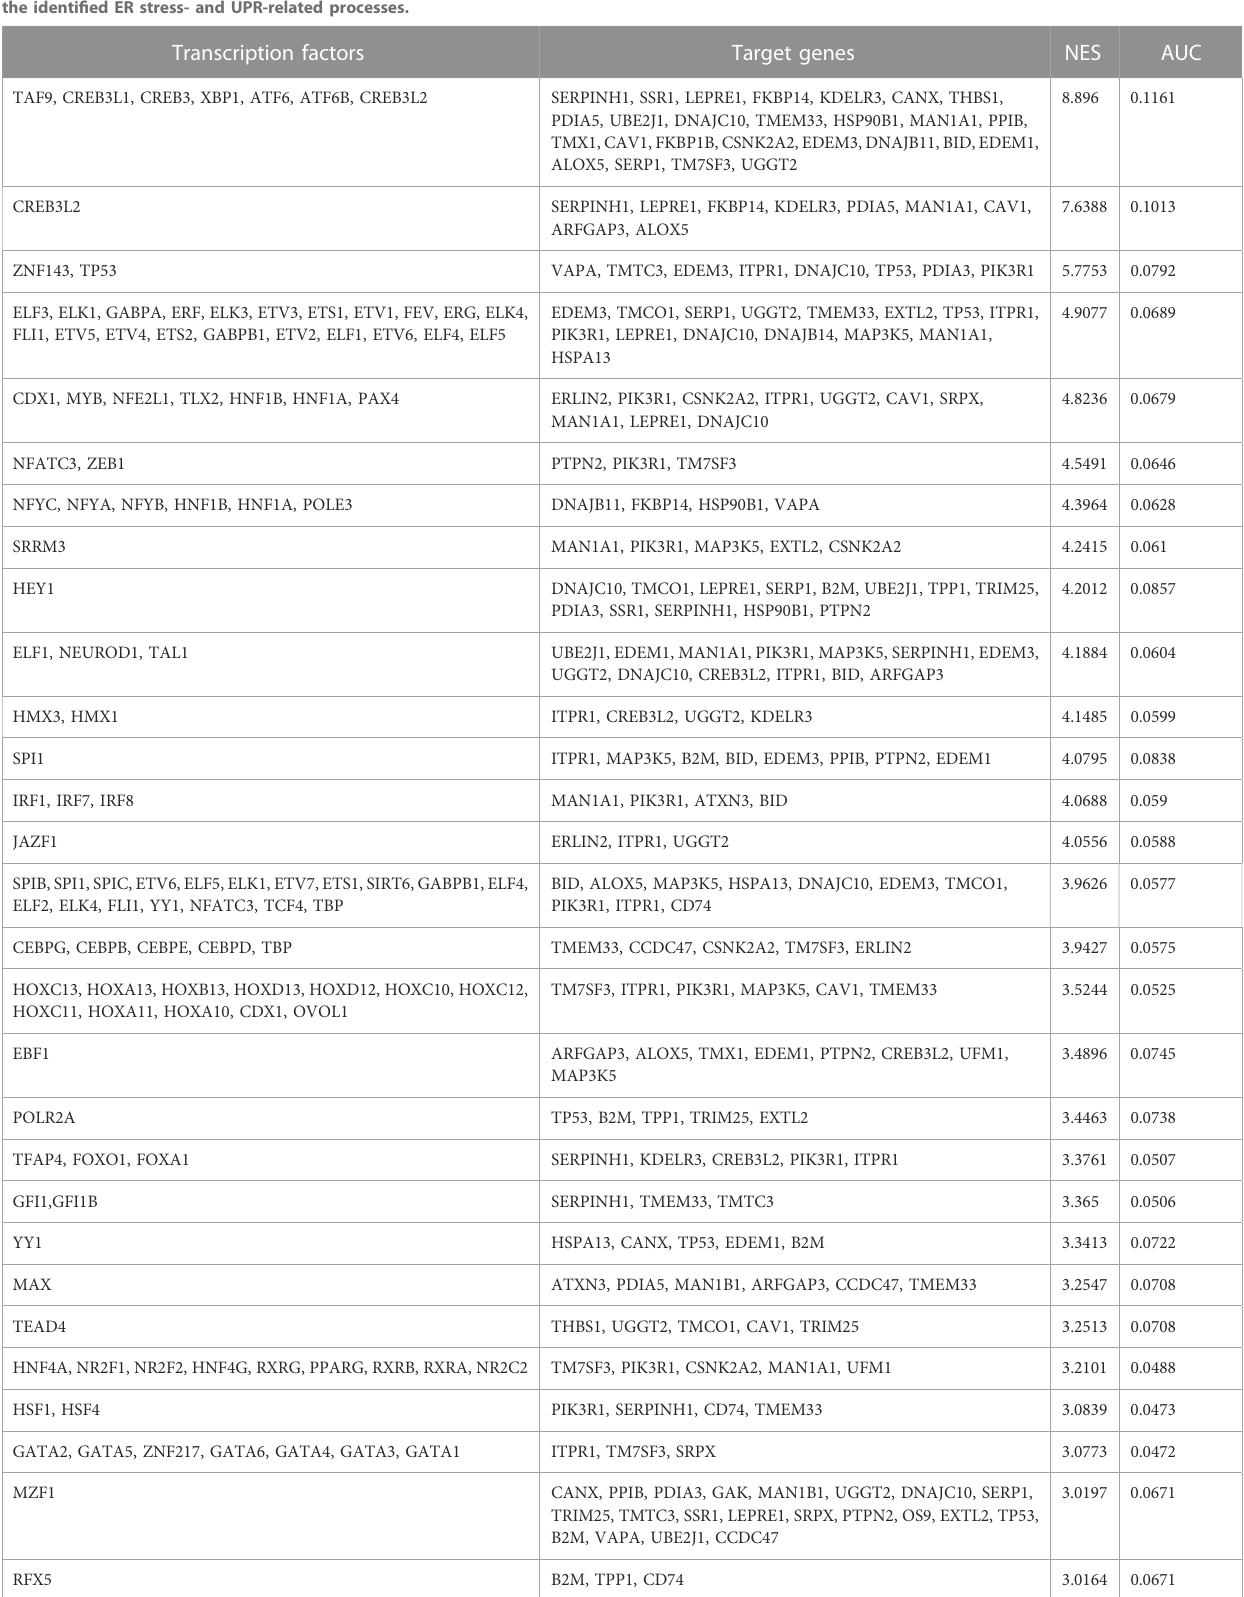
TABLE3Putativetranscriptionfactorswiththeirorthologuesandtargetgenesidenti fi edbasedonmotifandtracksearchesiniRegulon.Transcriptionfactorswith a normalized enrichment score (NES) > 3% and higher area under curve (AUC) are listed. The iRegulon analysis was performed on the 58 upregulated genes from the identi fi ed ER stress- and UPR-related